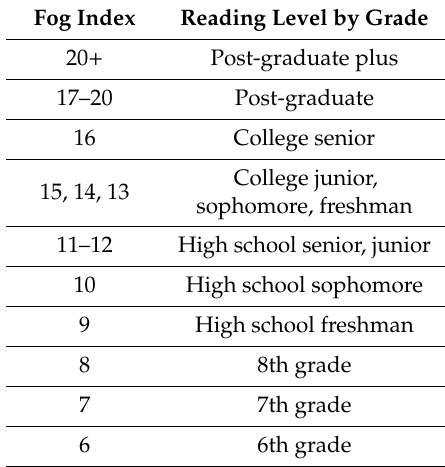
Table 3. Gunning’s fog-index level